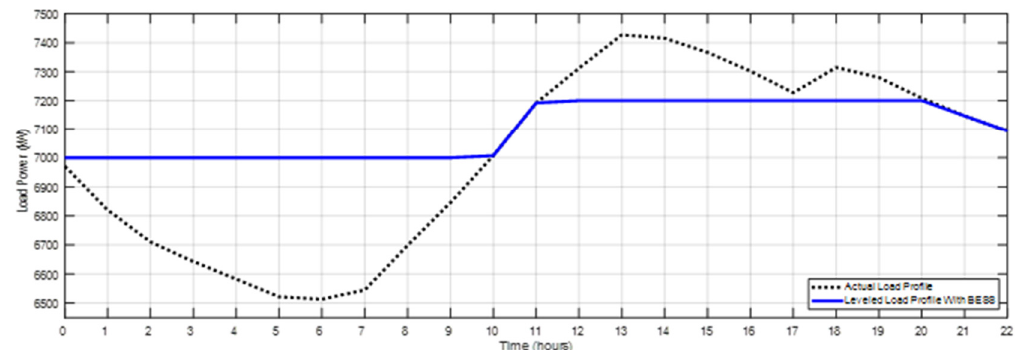
Figure 10. Aggregated Case: Minimum System load profile with / without BESS.